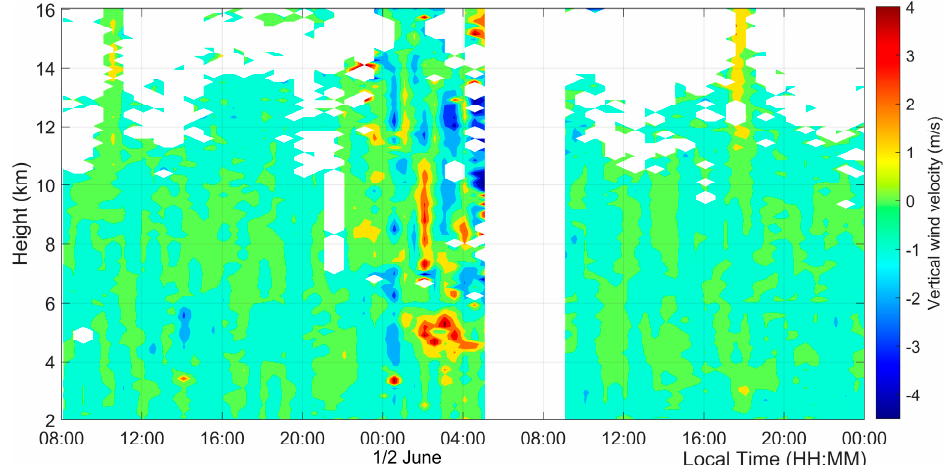
Figure 7. Vertical wind speed variations recorded by the Wuhan MST radar from 8:00 LT on 1 June to 24:00 LT on 2 June between 2 and 16 km heights. The upward velocity is negative. The white region indicates data missing at that time.